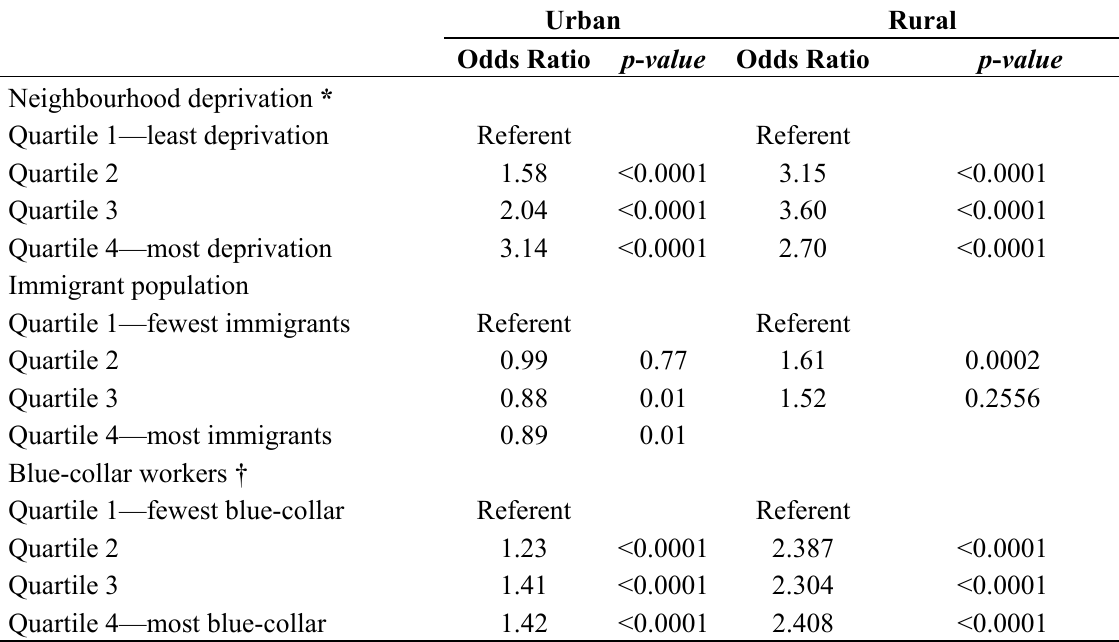
Table 2. Odds of having a tobacco retail outlet by neigbourhood (dissemination area) characteristics. ( n = 18,922 dissemination